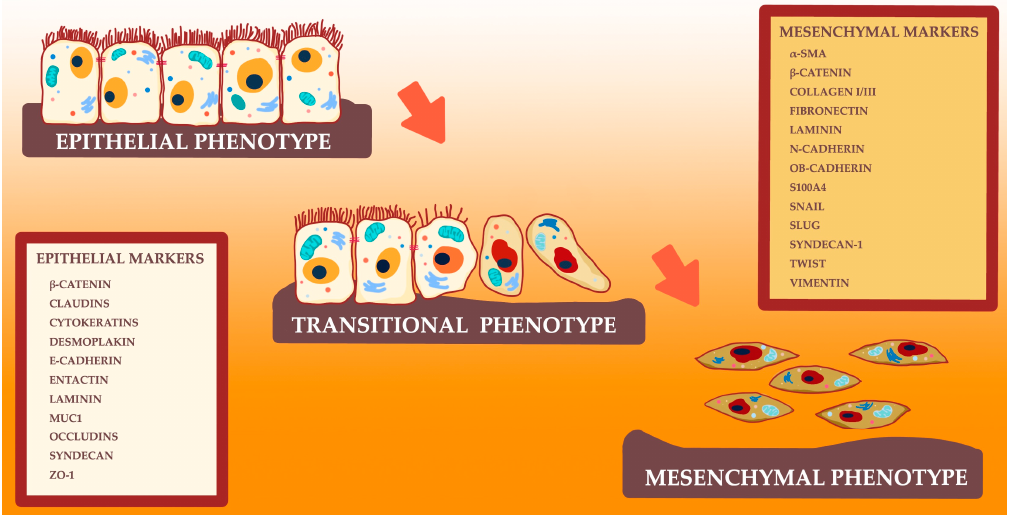
Figure 1. Schematic of the epithelial–mesenchymal transition and chosen epithelial and mesenchymal